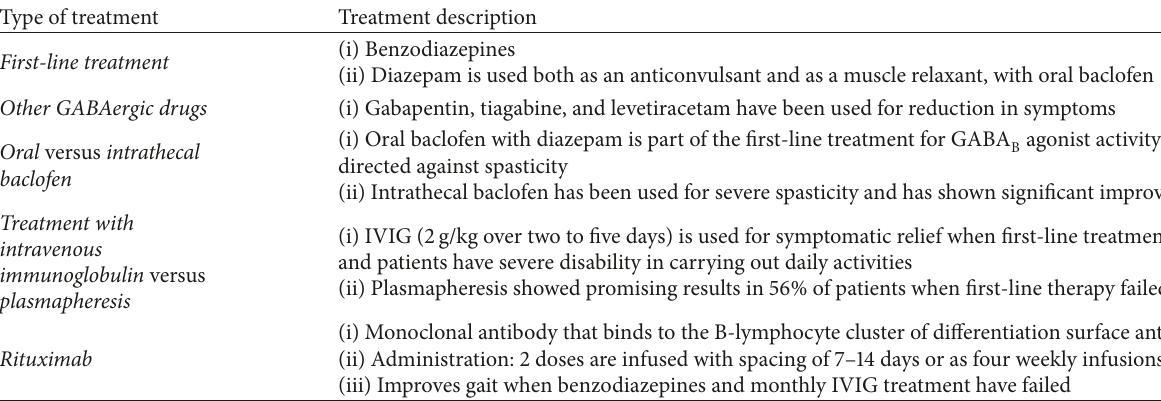
Table 2: Treatment options for stiff person